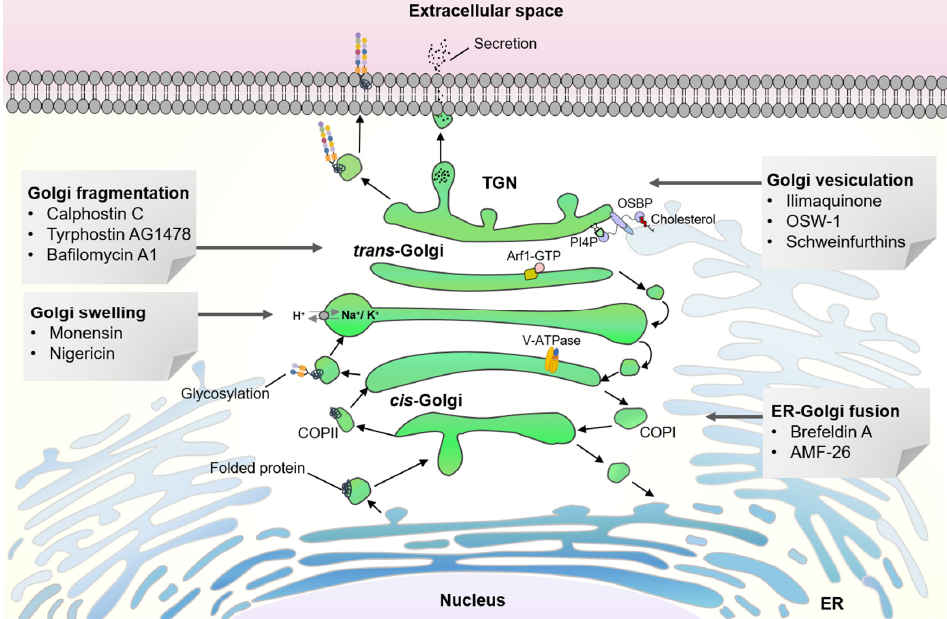
Figure 1. Structural organization of mammalian Golgi apparatus is important for vesicular transport, biosynthesis of glycans and lipids, post-translational modification of proteins and intracellular signaling.